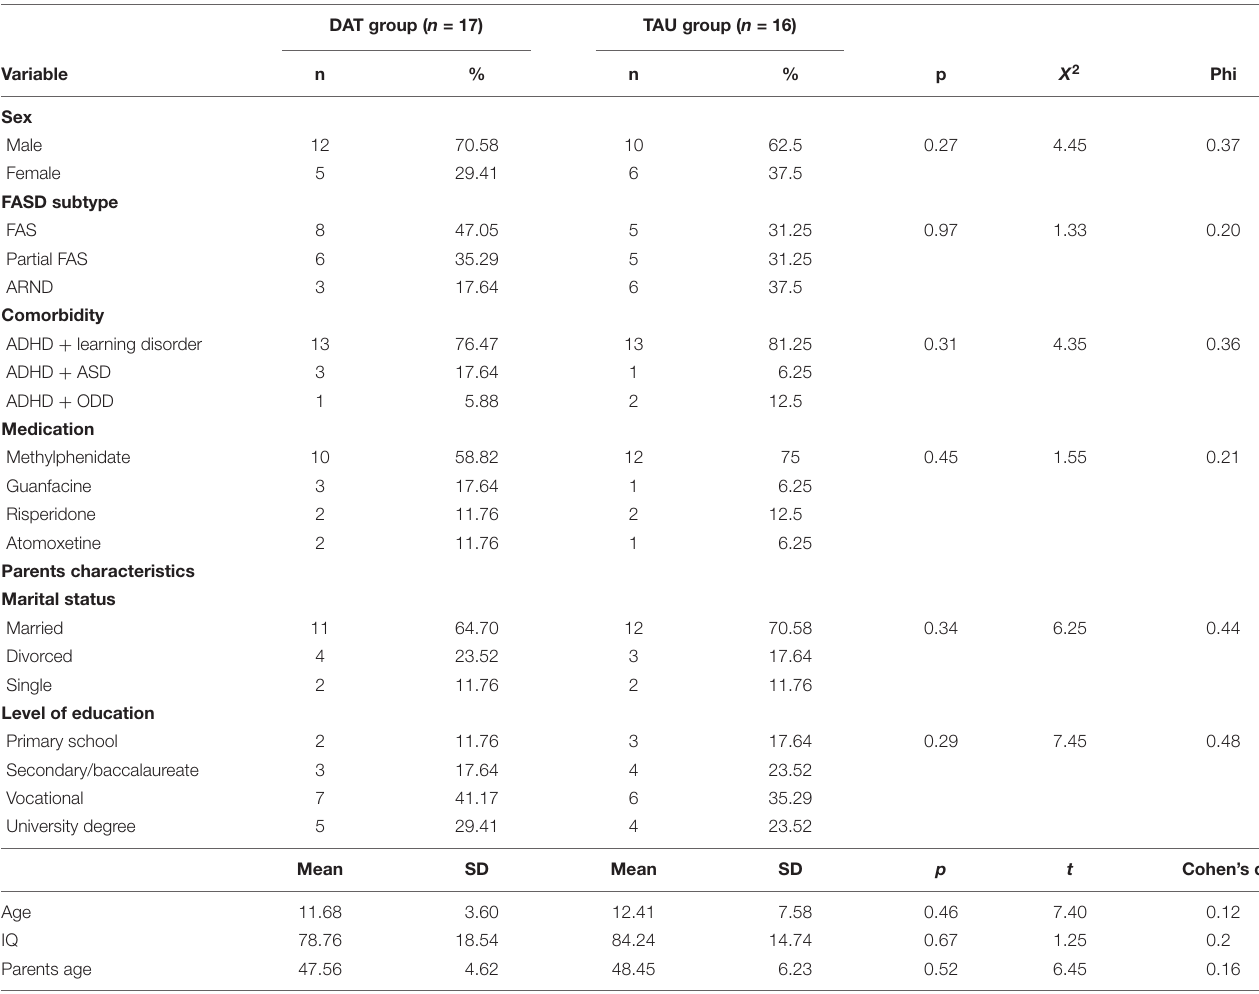
TABLE 1 | Participant’s